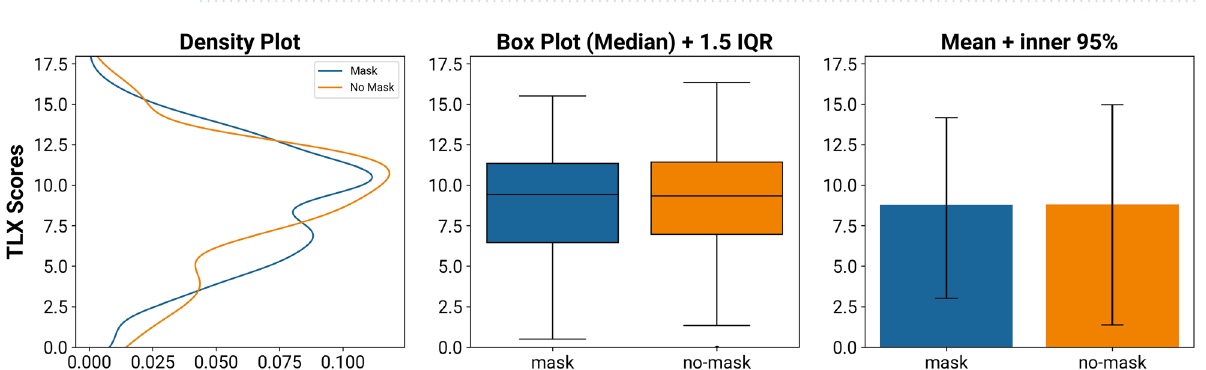
Figure 2. Comparison of the physiological metrics (blood oxygen level and HRV) while wearing an FFR and not wearing an FFR. The density plots to the left describe the similarity of the distributions of the two groups. The box-plots in the center column compare the median and the interquartile range (IQR) and provide an assessment of potential outliers. The bar charts to the right compare the plain mean of the two group; the whiskers depict the inner 95% of the recorded data.